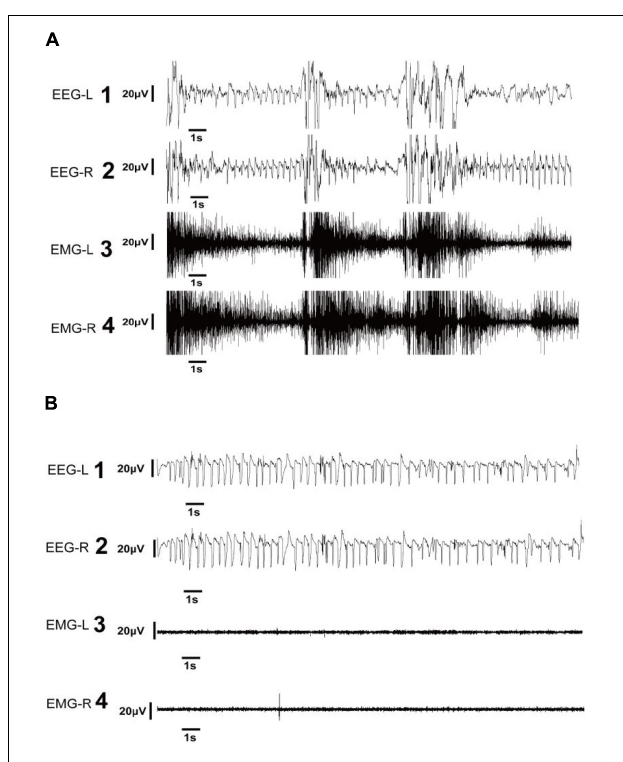
FIGURE 3 | Representative electroencephalography (EEG) of electroclinical and electrographic seizures. (A) EEG and electromyography (EMG) in the left and right panels show electroclinical seizure activities. Electroclinical seizures were defined as typical events that met electrographic and behavioral criteria. The EEG trace showing the seizure with high-frequency, large-amplitude spike activity during tonic phase of seizure (A1,2) accompanied by high-amplitude EMG recordings (A3,4) . (B) EEG and EMG in the left and right panels show electrographic seizure activities. Electrographic seizures were defined as seizures observed in the EEG with high-frequency, large-amplitude spikes (B1,2) , and with an EMG pattern exhibiting a low magnitude (B3,4) . EEG-L, EEG in the left cortex; EEG-R, EEG in the right cortex; EMG-L, EMG in the left neck muscle; EMG-R, EMG in the right neck